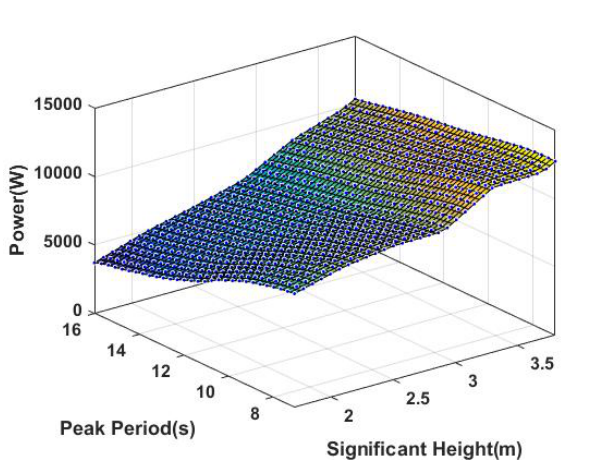
Fig. 17: The fitted power extraction of different waves with a high control